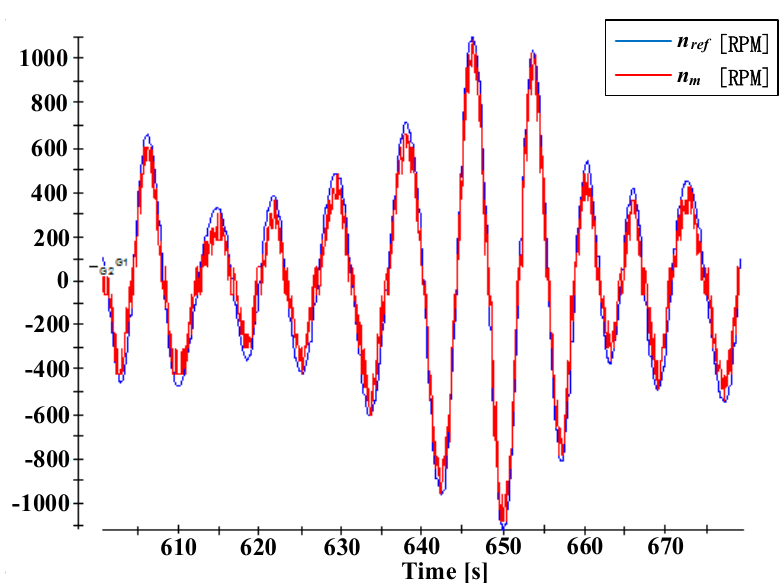
Figure 14. Measured speed vs. the reference speed of permanent magnet synchronous generator (PMSG).